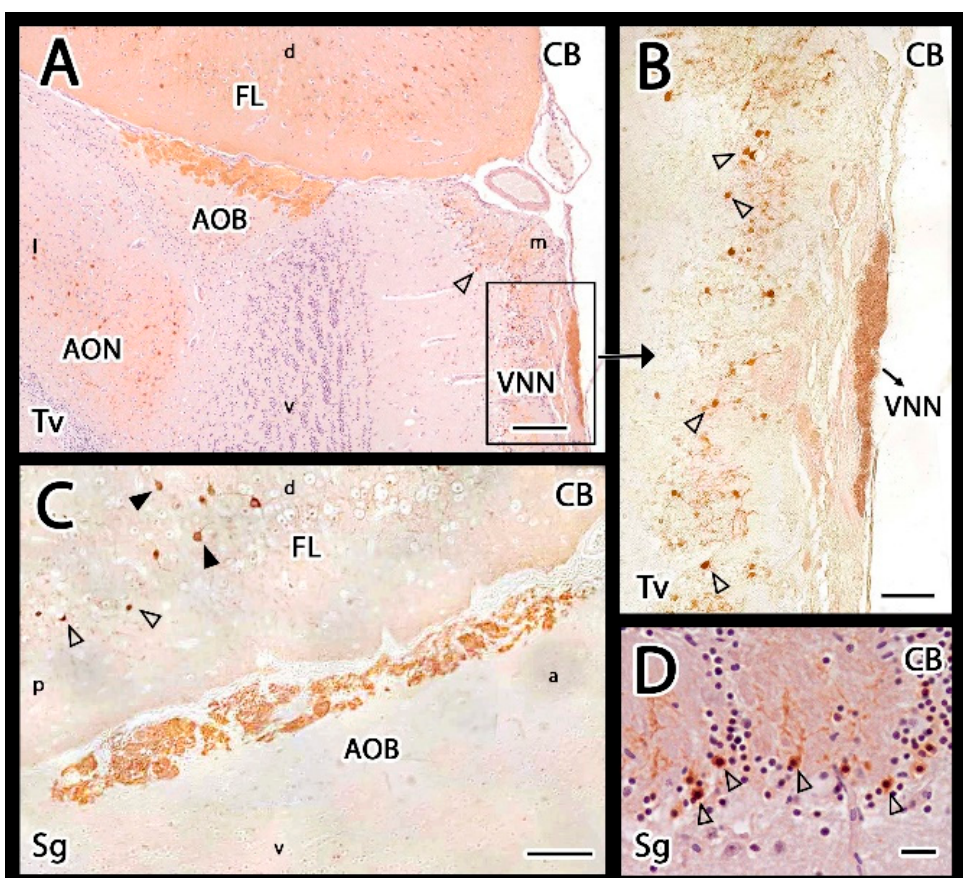
Figure 10. Immunolabelling with anti-calbindin (CB) in the olfactory bulb of the meerkat. ( A ) Trans- verse section of the olfactory bulb counterstained with hematoxylin showing strong immunopositivity to CB in the vomeronasal nerve (VNN), and in the neuropil of both the nerve and glomerular layers of the accessory olfactory bulb (AOB). Additionally, immunopositive neurons are observed in the cerebral cortex of the frontal lobe (FL), and the anterior olfactory nucleus (AON). ( B ) Enlargement of the inset in ( A ), not counterstained, showing the strong immunopositivity of the VNN (arrow) and the immunolabelling pattern of the main olfactory bulb (MOB). The arrowheads point to positive periglomerular cells belonging to the glomeruli of the MOB. ( C ) Sagittal section confirming the CB-immunopositivity of the AOB in its glomerular and nerve layers. Immunopositive cells with multipolar (black arrowheads) and granular (open arrowheads) morphology are observed in the FL. ( D ) Hematoxylin counterstaining in the glomerular layer of the MOB shows that only a subpop- ulation of periglomerular cells is CB-immunopositive (open arrowheads). Scale bars: ( A , C ) 100 μ m; ( B , D ) 50 μ m.